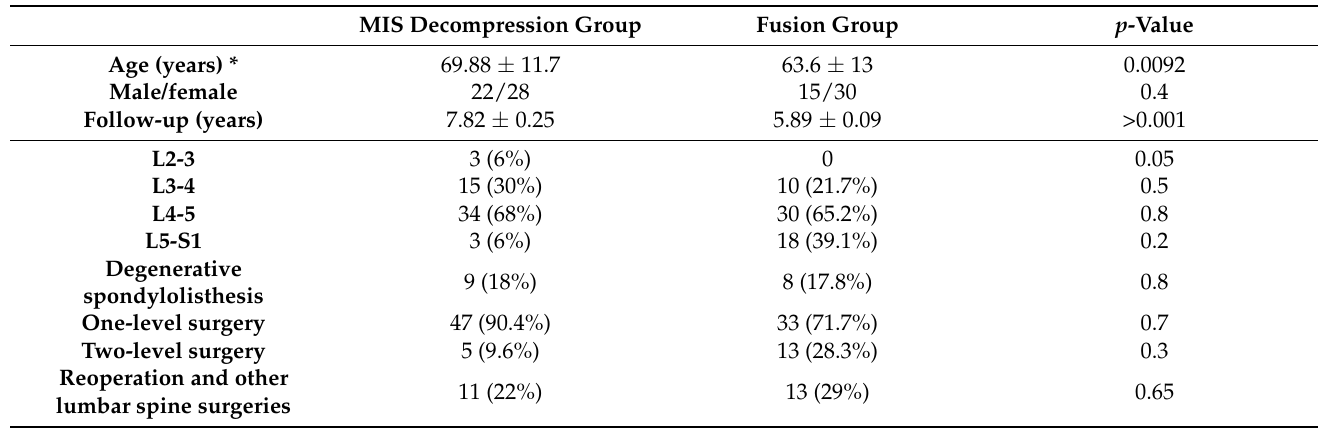
Table 1. Demographic data and radiological and surgical characteristics of both groups.